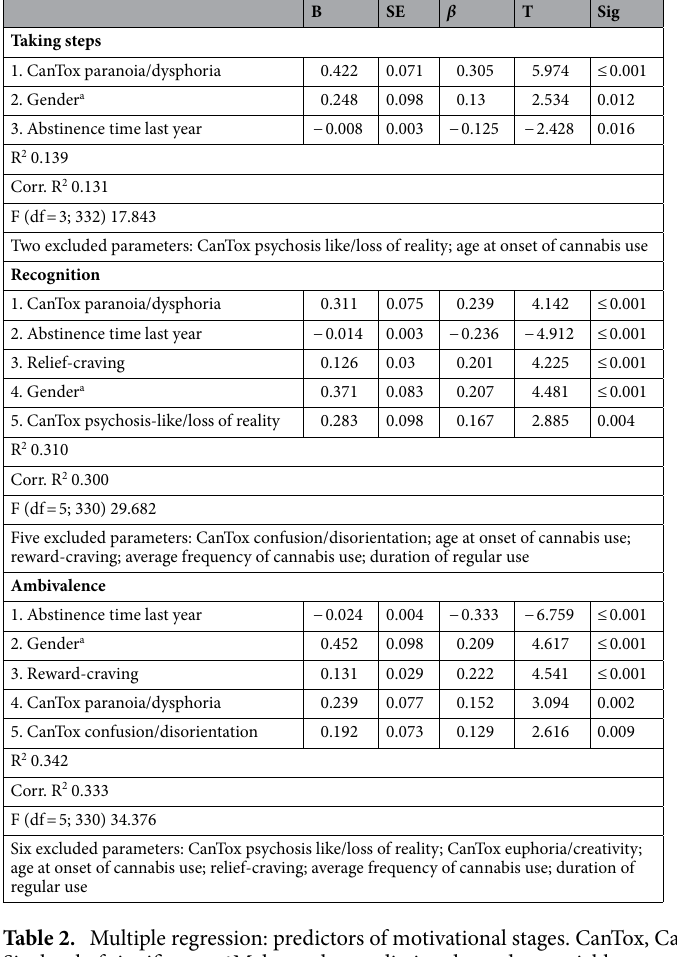
Table 2. Multiple regression: predictors of motivational stages. CanTox, Cannabis-intoxication questionnaire; Sig, level of significance; a Male gender predicting dependent